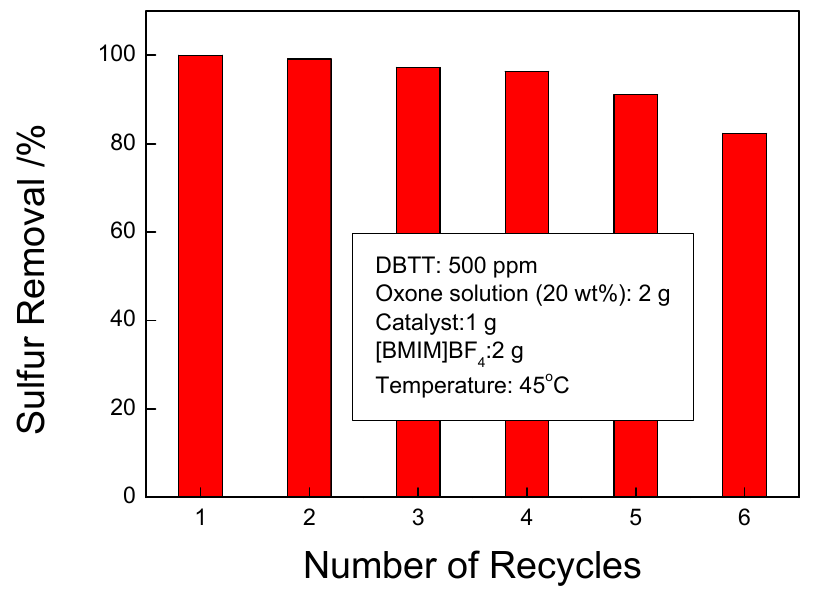
Figure 10. The recycling performance of di-[EMIM]CoCl 3.